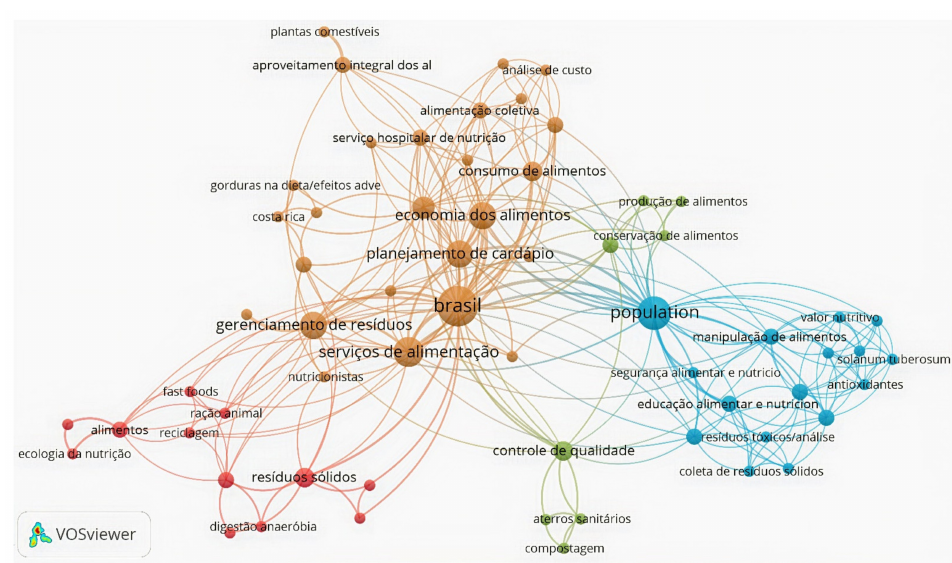
Figure 4. LILACS keywords co-occurrence